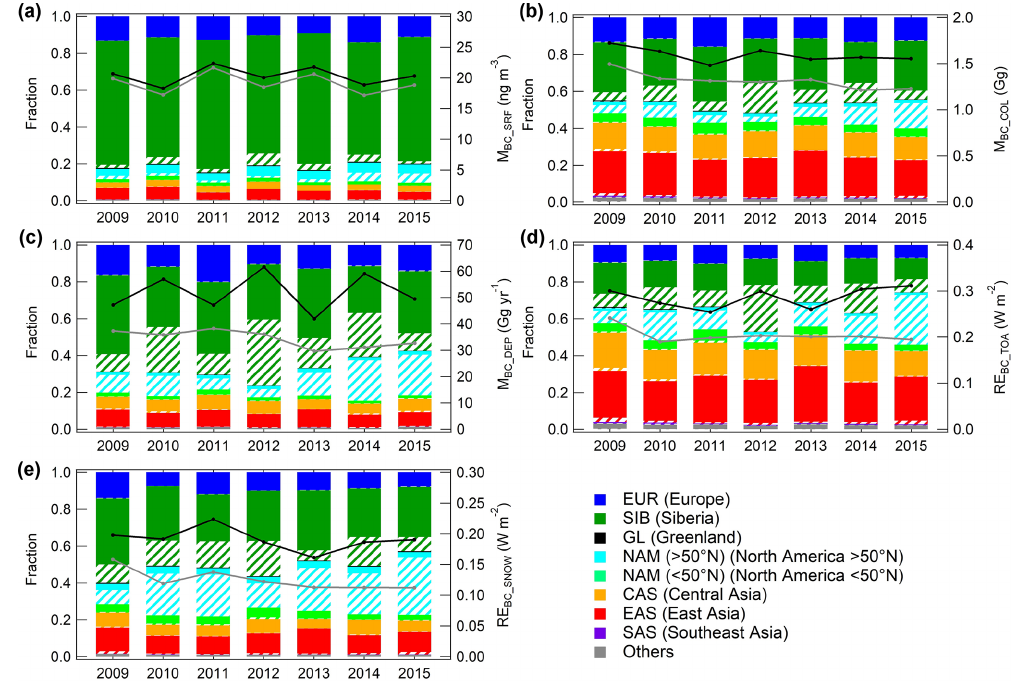
Figure 10. Year-to-year variations of annual-mean source contributions to (a) M BC_SRF , (b) M BC_COL , (c) M BC_DEP , (d) RE BC_TOA , and (e) RE BC_SNOW in the Arctic for the years from 2009 to 2015 (left axis). The filled and shaded areas indicate contributions from anthropogenic and biomass burning sources, respectively. The black and grey lines show BC concentrations, deposition flux, or radiative effects from all (anthropogenic + biomass burning) sources and from anthropogenic sources, respectively (right